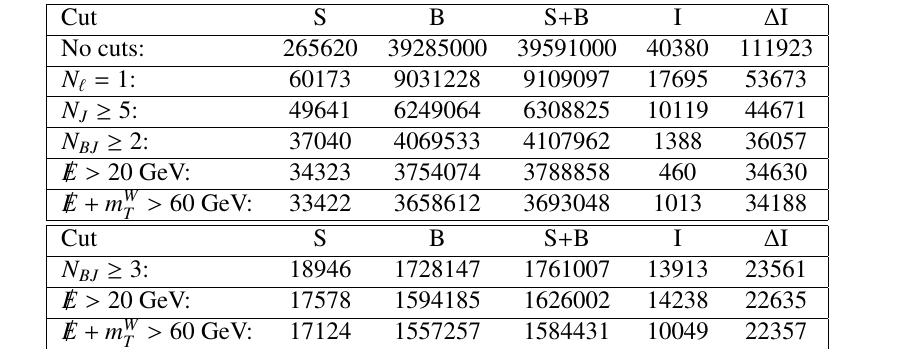
Table 3. Cut flow results presented in expected event yield with 3000fb − 1 of luminosity for the m mod +